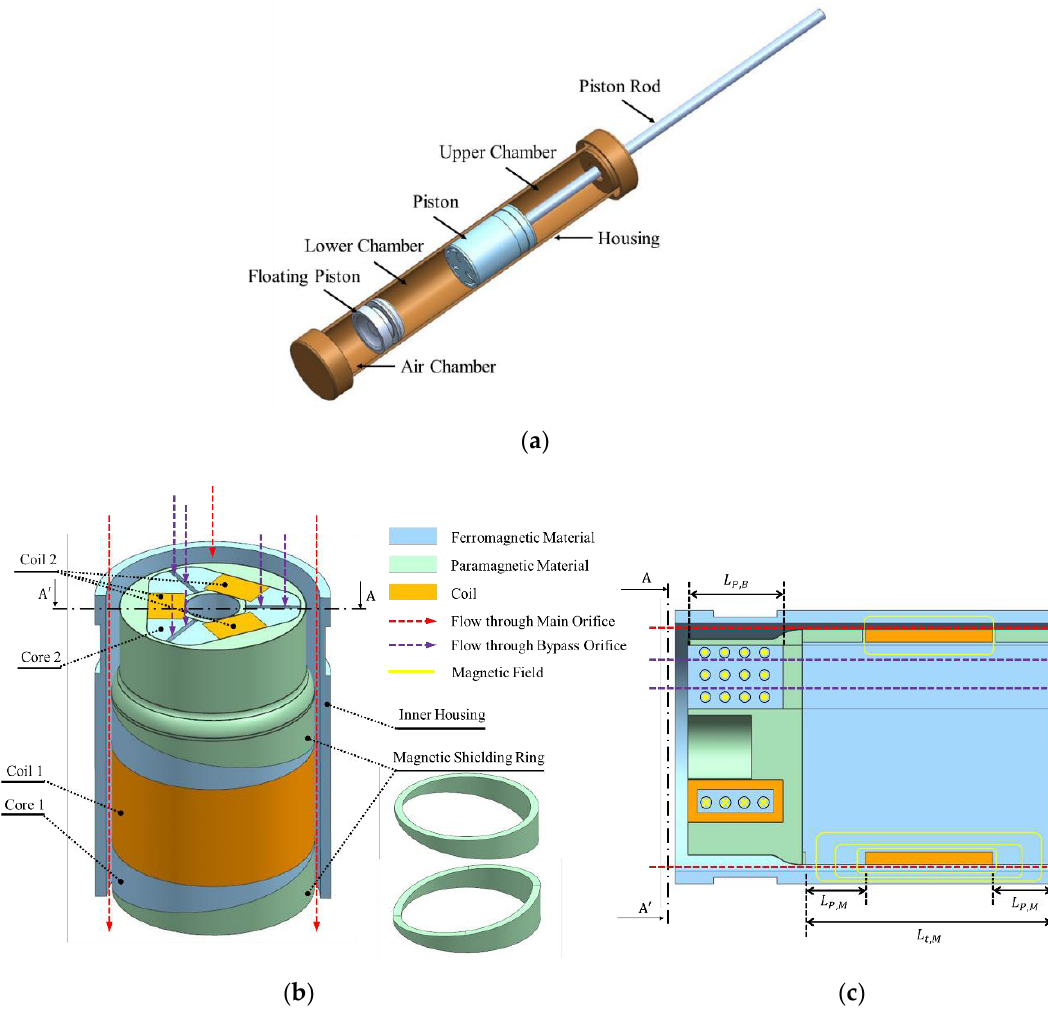
Figure 3. Configuration of the proposed MRD-PSF: ( a ) overall schematic; ( b ) core part; and ( c ) A − A′ section view.